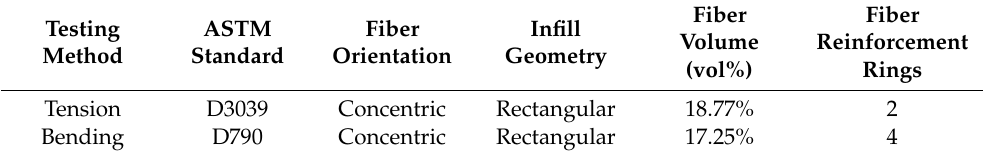
Table 2. Sample configuration for mechanical characterization of Onyx™–Kevlar ®